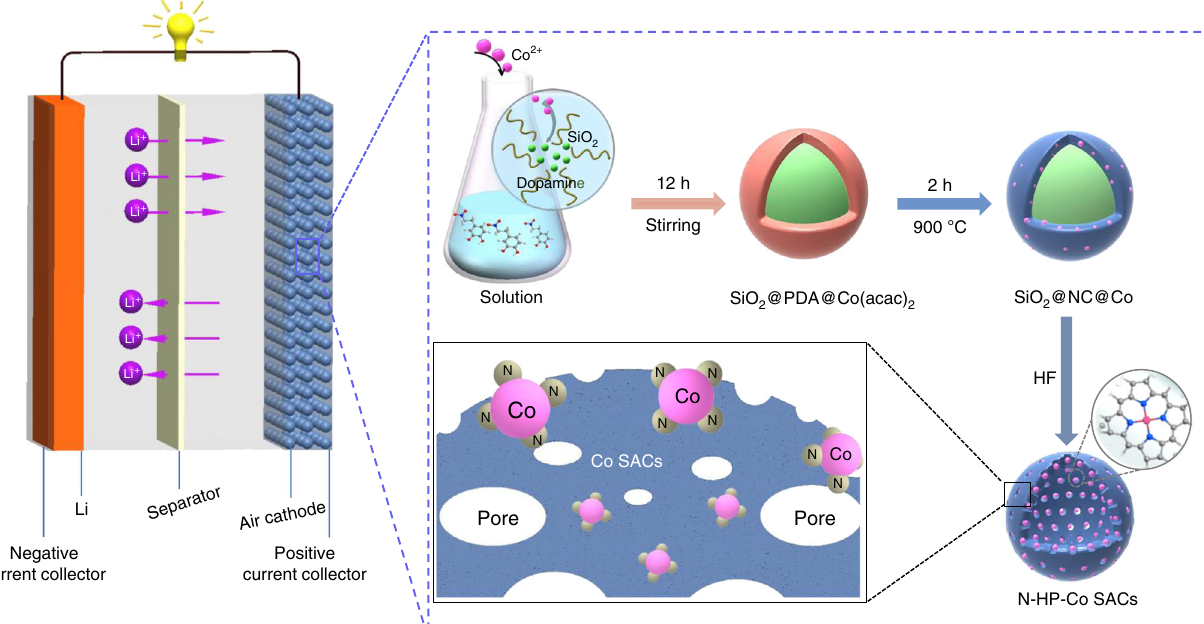
Fig. 1 Schematic illustration showing the synthesis of N-HP-Co SACs. The composition in the cell (left) and the synthesis procedures for the N-HP-Co SACs